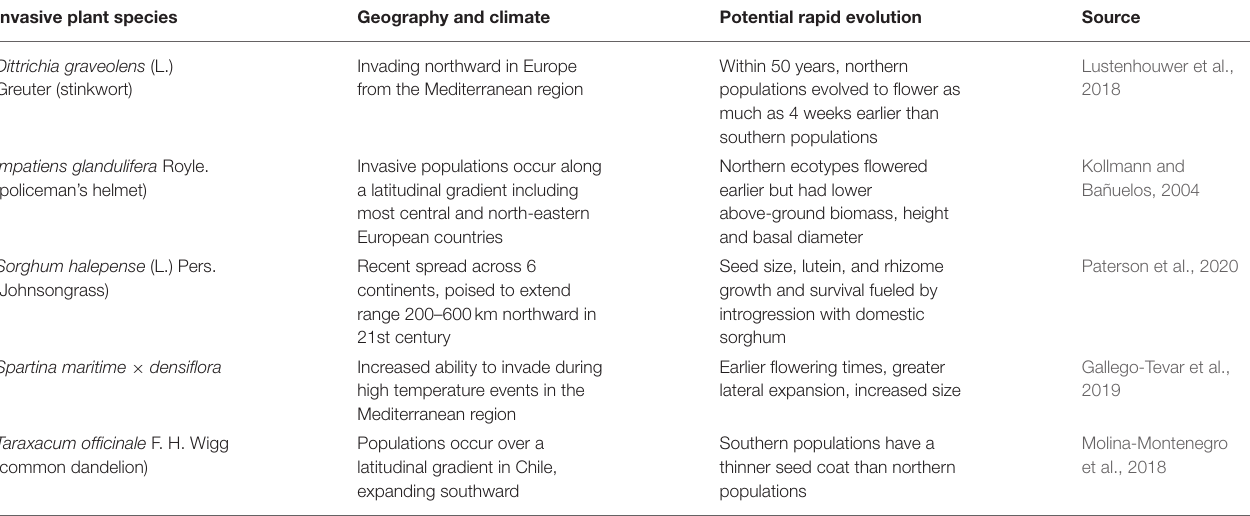
TABLE 2 | Cases demonstrating potential rapid evolution of invasive plants under climate change for species evolving along latitudinal